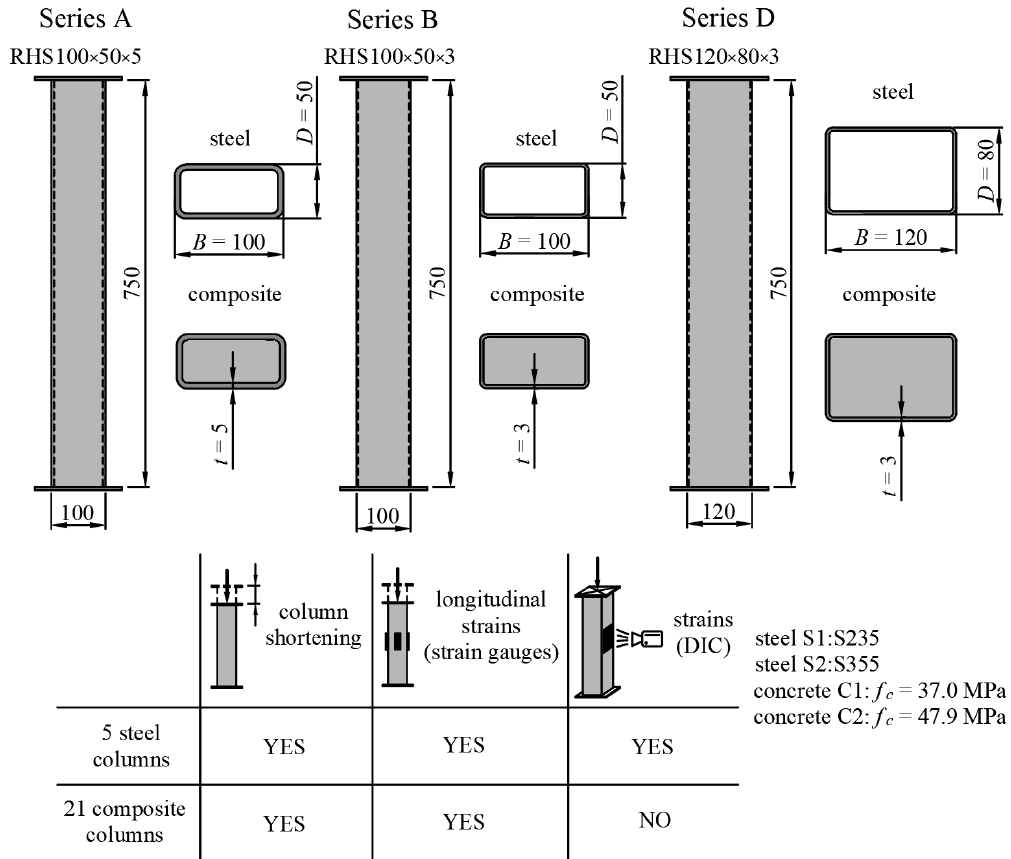
Figure 9. Design schemes and descriptions of the measurements performed on the investigated columns.